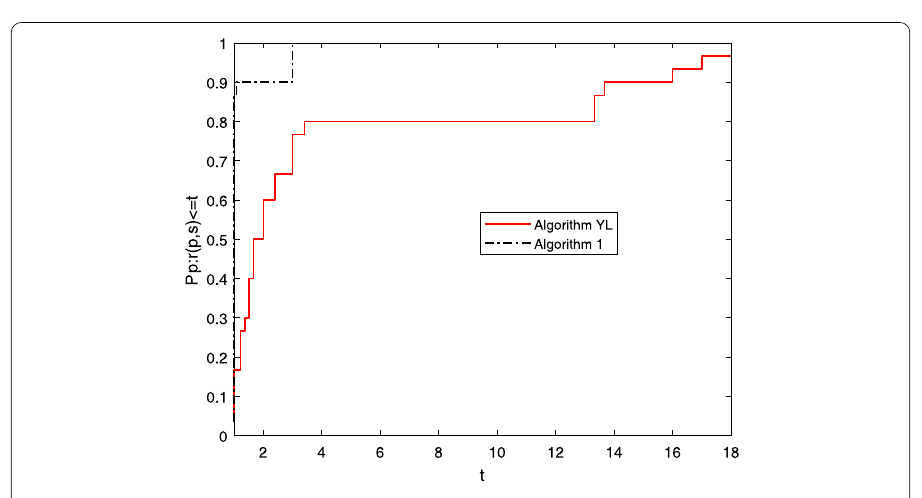
Figure 1 Performance profiles of these methods